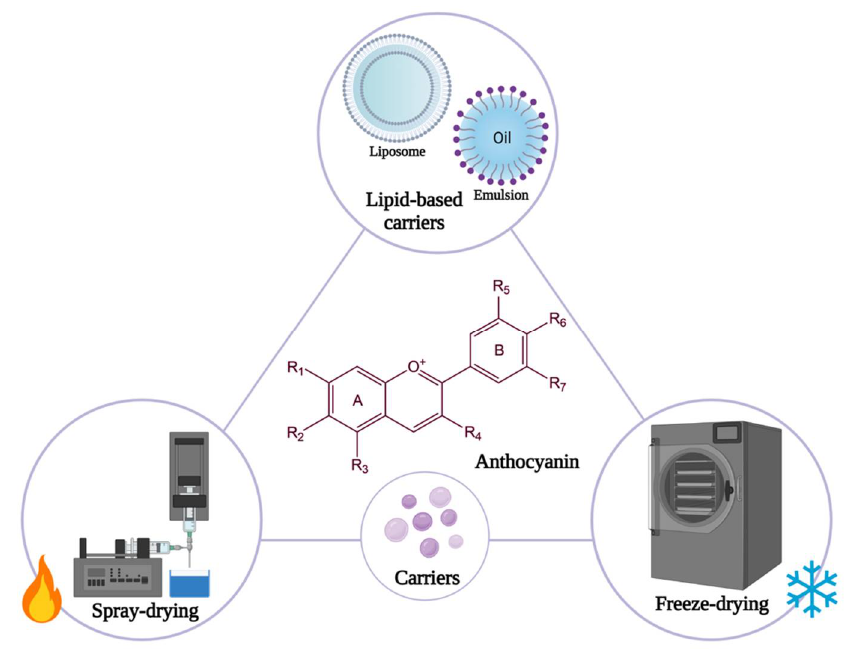
Figure 7. Methods for anthocyanins